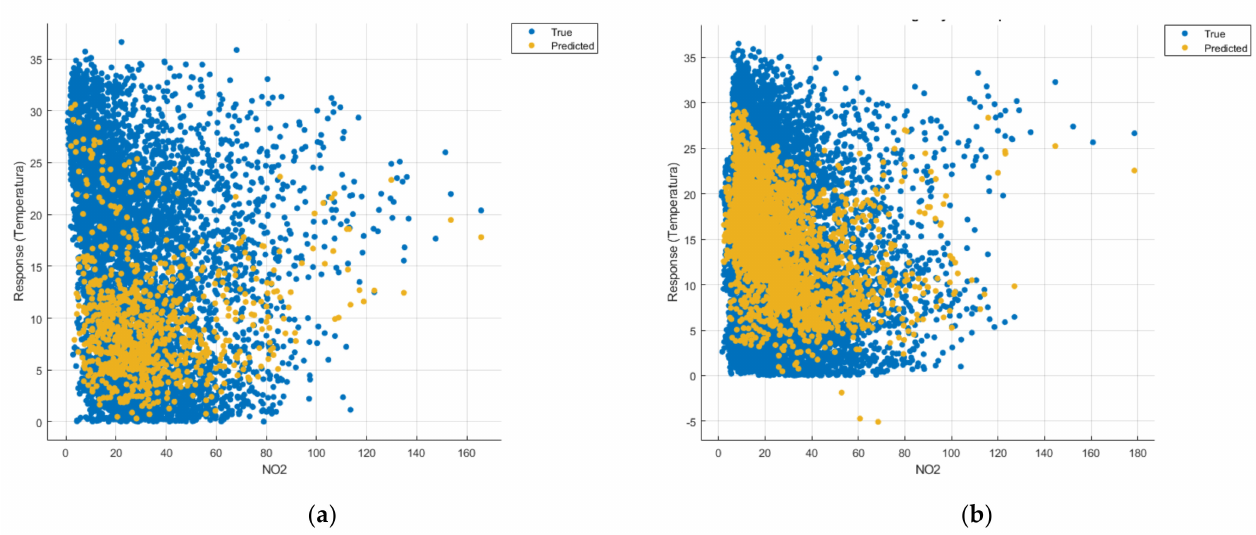
Figure 19. Prediction considering only NO 2 —optimised GPR. ( a ) March 2019–February 2020, ( b ) March 2020–February